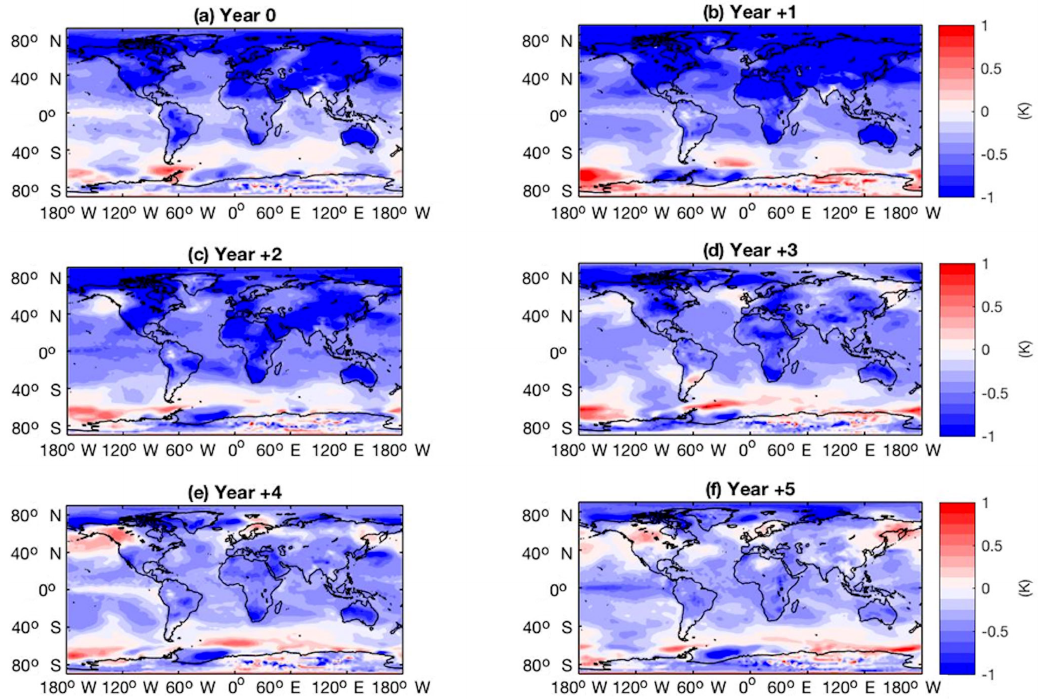
Figure 3. Global SST anomalies (K) in response to the CR forcings, showing multi-ensemble mean response over JASON averaged across all analysed eruptions for years 0 to + 5 after eruption.